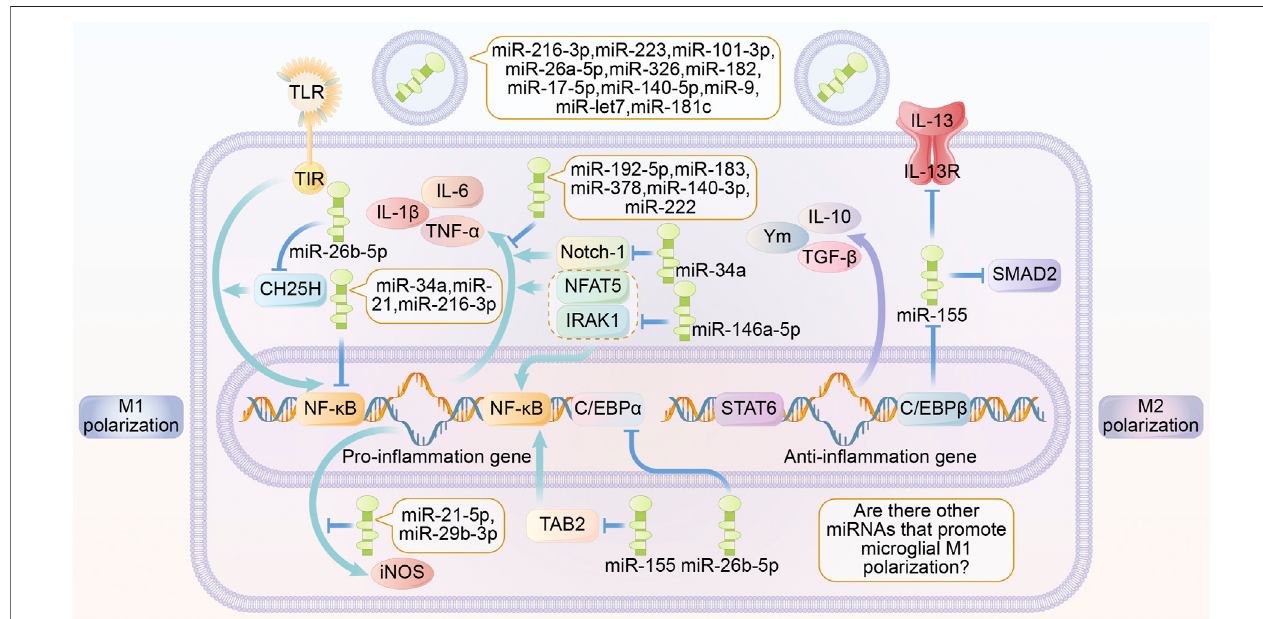
FIGURE 1 | Roles of exosome miRNA in microglia polarization. Different miRNAs secreted by exosomes are able to play a role in regulating microglia polarization through multiple signaling pathways. miR-216-3p, miR-223, miR-101-3p, miR-26a-5p, miR-326, miR-182, miR-17-5p, miR-140-5p, miR-9, miR-let7, miR-181c are able to inhibit TLR expression. miR-192-5p, miR-183, miR-378, miR-140-3p, miR -222 are able to directly inhibit the expression of in fl ammatory factors. miR-26b-5p inhibits the TLR signaling pathway by suppressing the expression of CH25H. miR-34a, miR-21, miR-216-3p are able to directly inhibit the expression of NF- κ B. miR — 21-5p,andmiR-29b-3pinhibitstheexpressionofthepro-in fl ammatoryfactoriNOS.miR-155inhibitsNF- κ BactivationbysuppressingTAB2.miR-26b-5pinhibits C/EBP α expression. miR-146a-5p inhibits the expression of IRAK1 and NFAT5, thereby suppressing the expression of in fl ammation-associated genes and products. miR-34a inhibits the expression of Notch- κ B. MiR-34a is able to inhibit Notch-1. The above miRNAs promote microglia M2 polarization and anti-in fl ammatory factor production. miR-155 promotes microglia M1 polarization and in fl ammatory factor production by inhibiting the expression of IL-13 receptor, SMAD2 and C/EBP β . Abbreviations:TLR,tolllikereceptor; iNOS,induciblenitricoxidesynthase; TGF β ,transforminggrowthfactor β ;Ym,chitinase-likeproteins;C/EBP α ,CCAAT/enhancer- binding protein α ; C/EBP β , CCAAT/enhancer-binding protein β ; TNF- α , tumour necrosis factor α ; STAT6, signal transducer and activator of transcription 6; NF- κ B, Nuclear factor kappa B; NFAT5, nuclear factor of activated T cells 5; IRAK1, interleukin-1 receptor-associated kinase1; TAB2, TGF-Beta-Activated Kinase 1-Binding Protein 2; SMAD2, Sma- And Mad-Related Protein